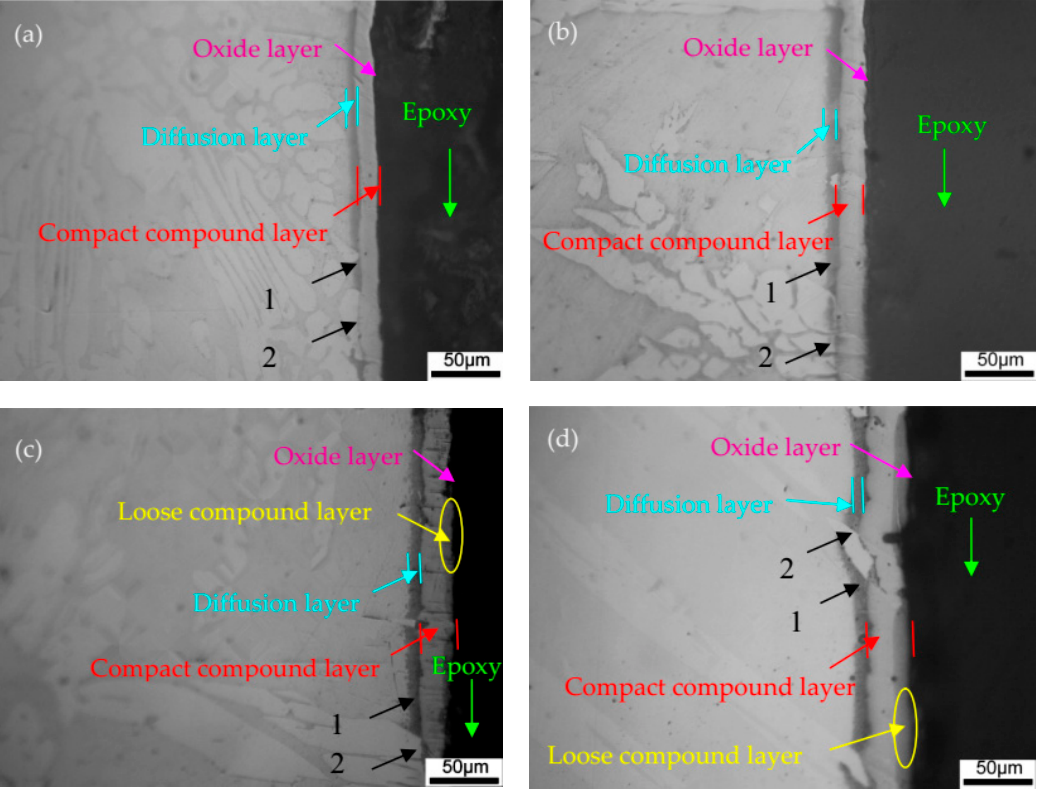
Figure 1. Cross-sectional microstructure of the samples nitrided at different temperatures: ( a ) 550 °C; ( b ) 570 °C; ( c ) 590 °C; ( d ) 610 °C.